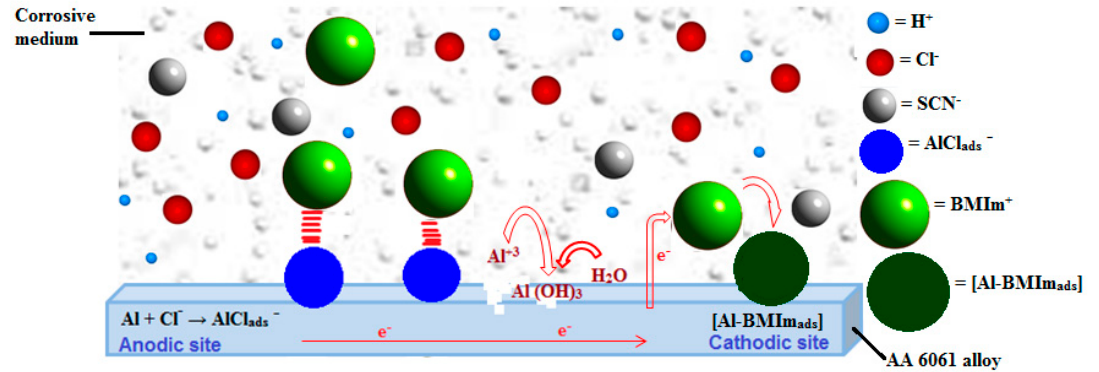
Figure 10. Mechanism of corrosion protection by BMIm IL in 1 M HCl medium.